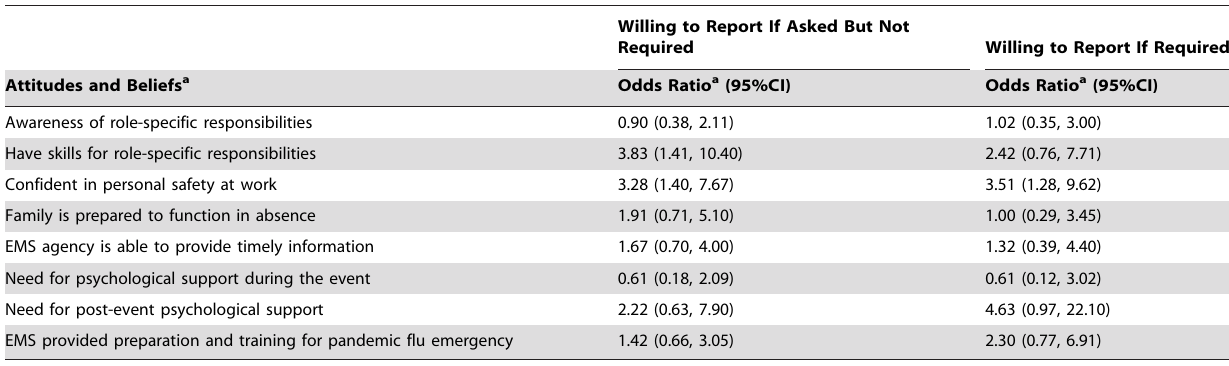
Table 5. Weighted multivariate logistic regression analyses to evaluate the associations between willingness-to-report scenarios and selected attitudes and beliefs regarding a pandemic influenza emergency (adjusted for other